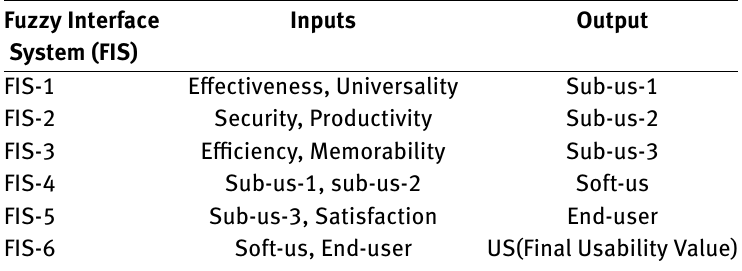
Table 5: Decomposing Inputs & outputs to minimize the total rules.